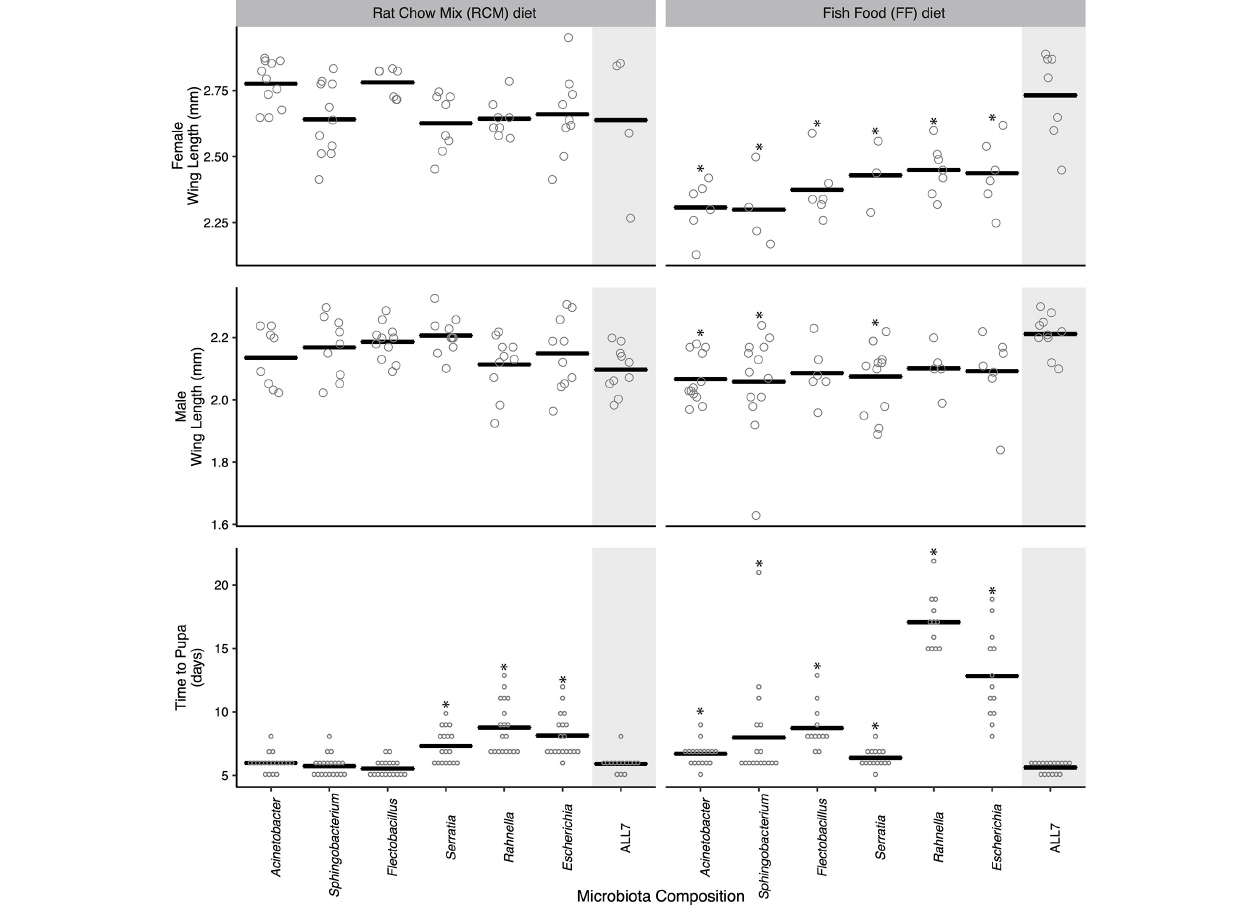
FIGURE 1 | Mosquito development time and adult size when reared monoxenically with different microbiotas on RCM or FF diet. Bars indicate mean abundance for the treatment. Asterisks indicate a significant difference for treatment relative to the community microbiota control = ALL7 [wing length, Dunnett’s ( p < 0.05); pupation time, Steel’s ( p <